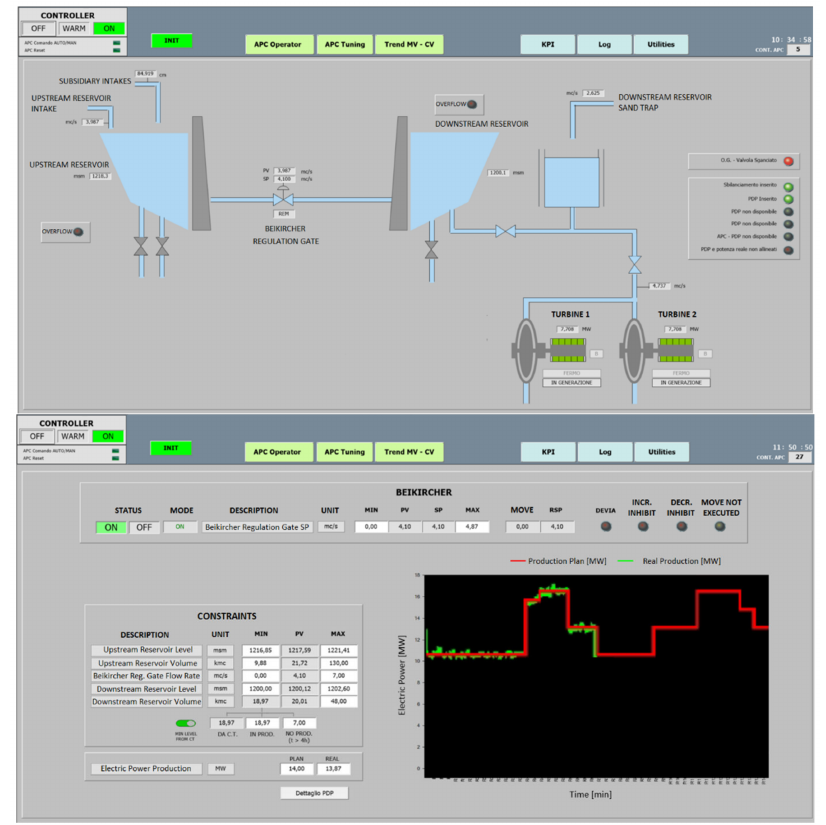
Figure 8. Results: panels of the GUI of the APC